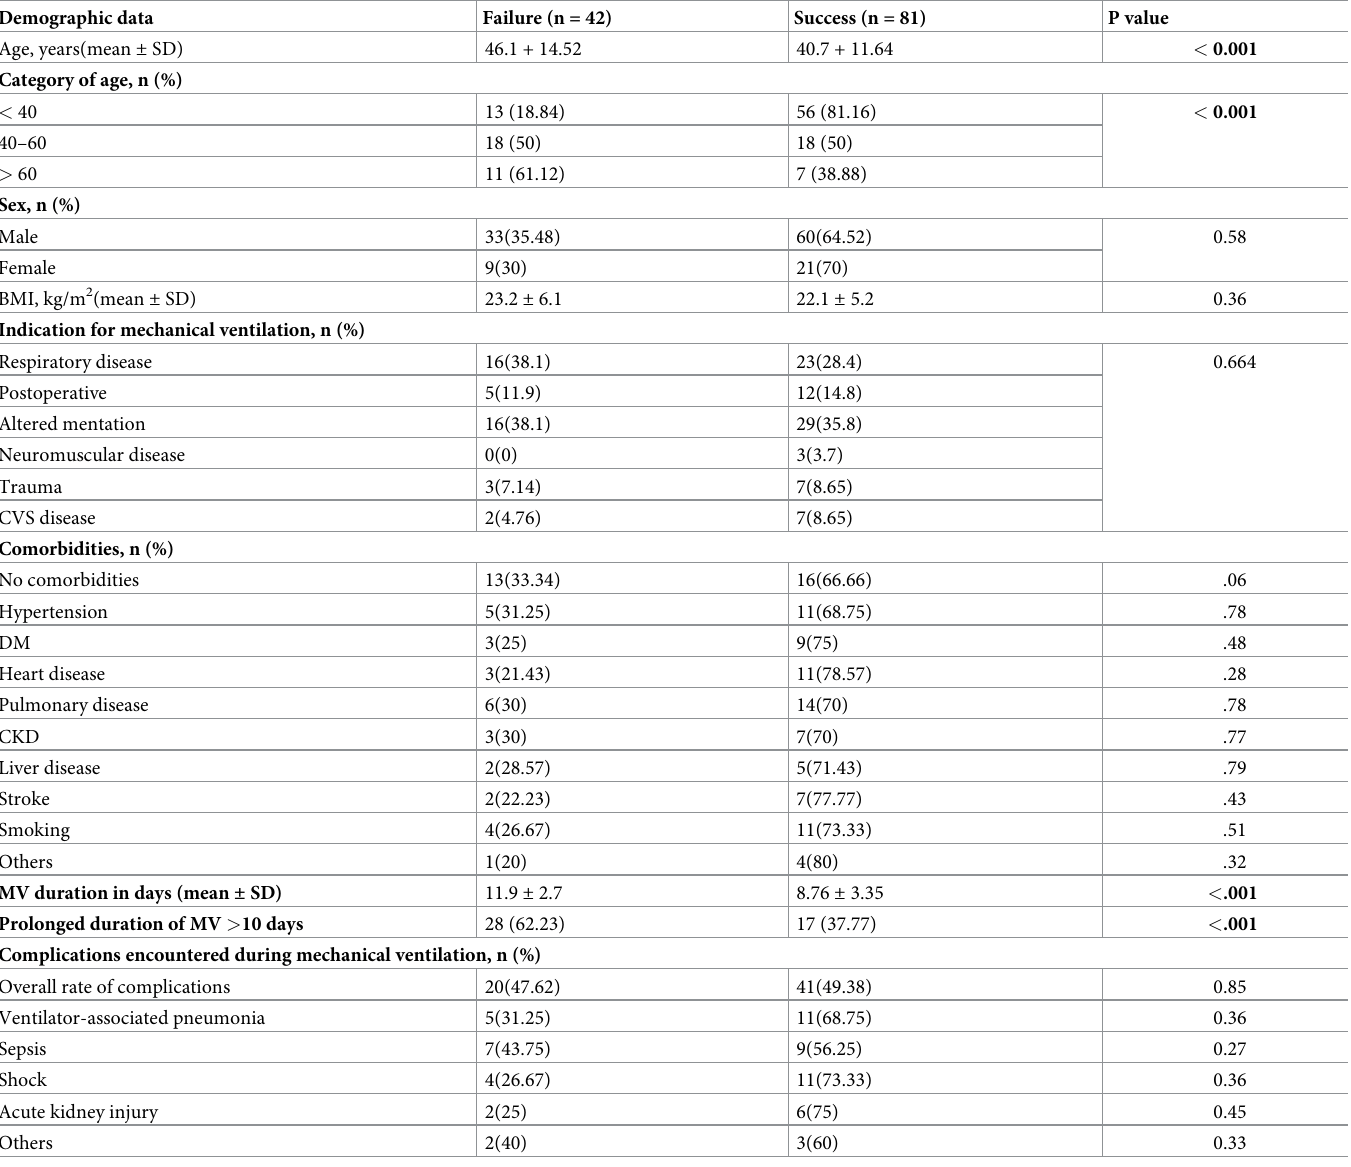
Table 1. Baseline characteristics between the extubation success and failure